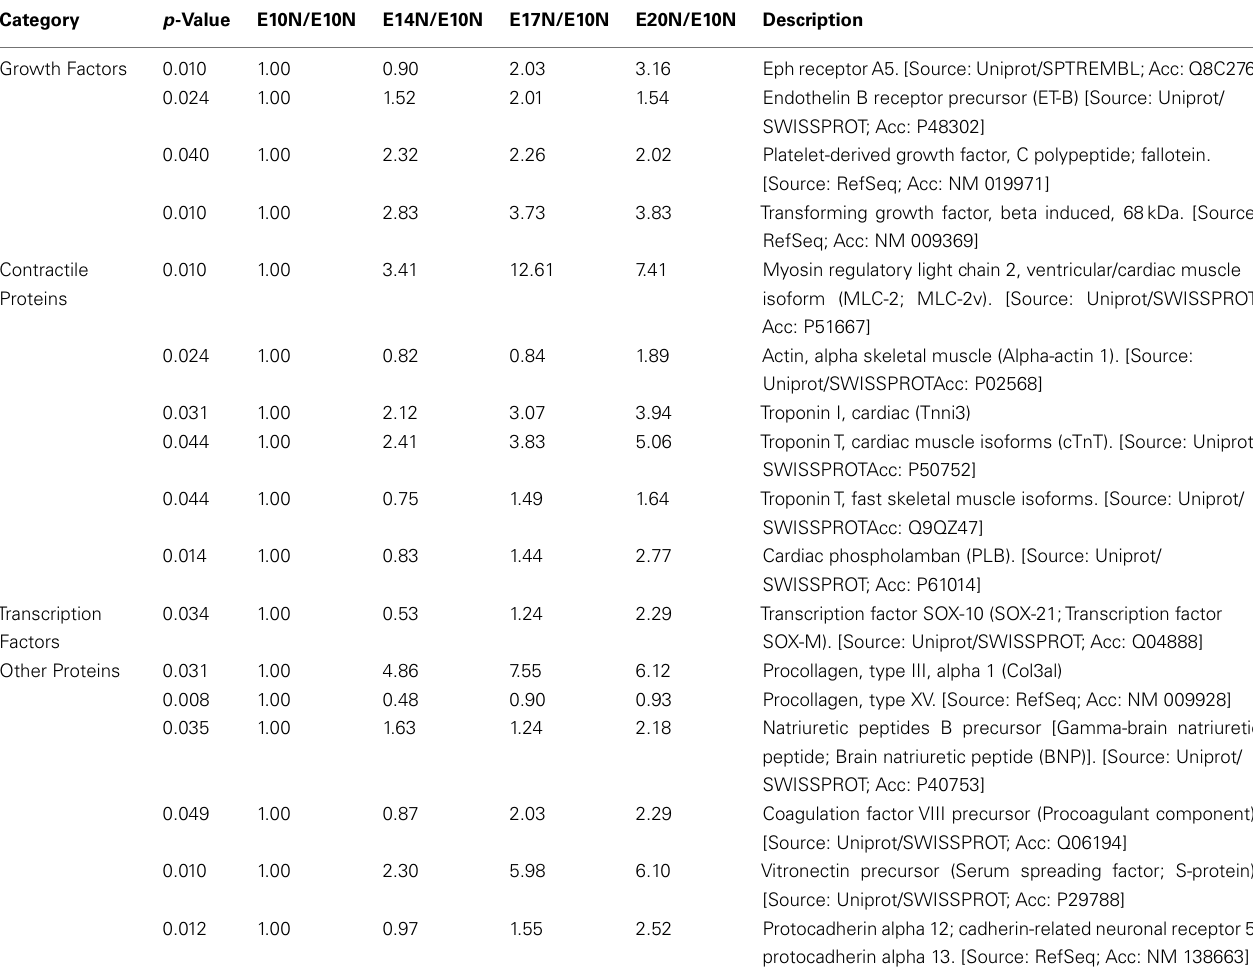
Table 1 | Microarray analysis of selected genes of interest from a total of 357 genes that are at least twofold up- or down-regulated ( p < 0.05; n = 3) across age namely E10, E14, E17, and E20 when subjected to normoxic treatment.